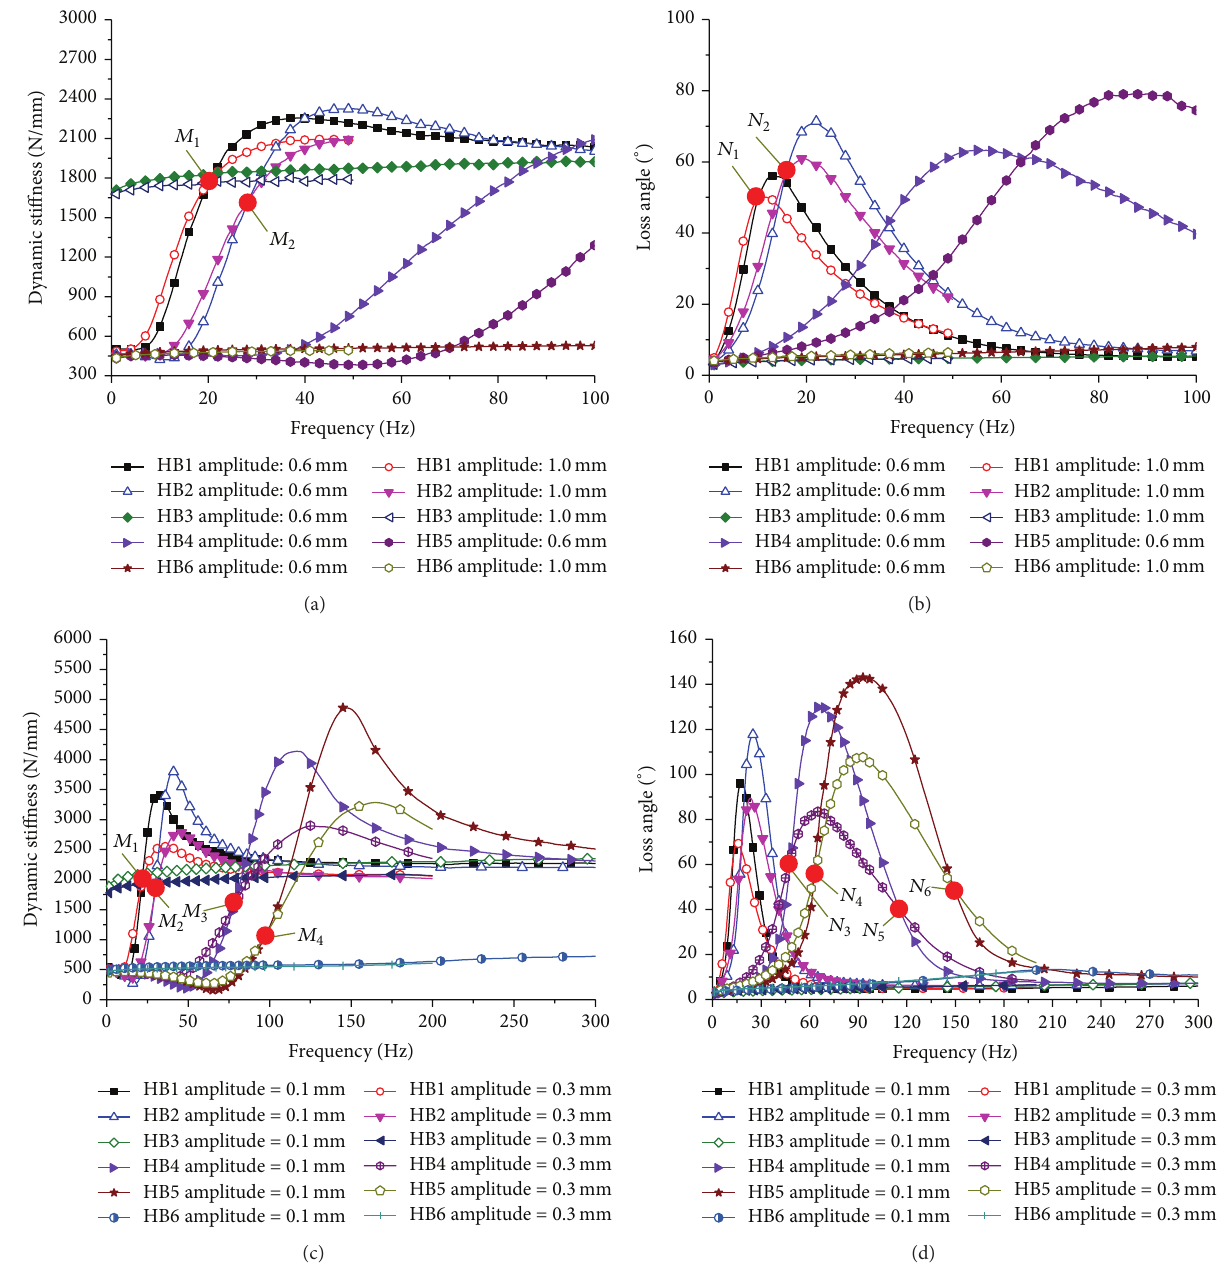
Figure 5: The dynamic test results of HDBs with different internal configurations. (a) Dynamic stiffness under low frequency band, large amplitude excitations; (b) loss angle under low frequency bands, large amplitude excitations; (c) dynamic stiffness under high frequency band, small amplitude excitations; (d) loss angle under high frequency band, small amplitude